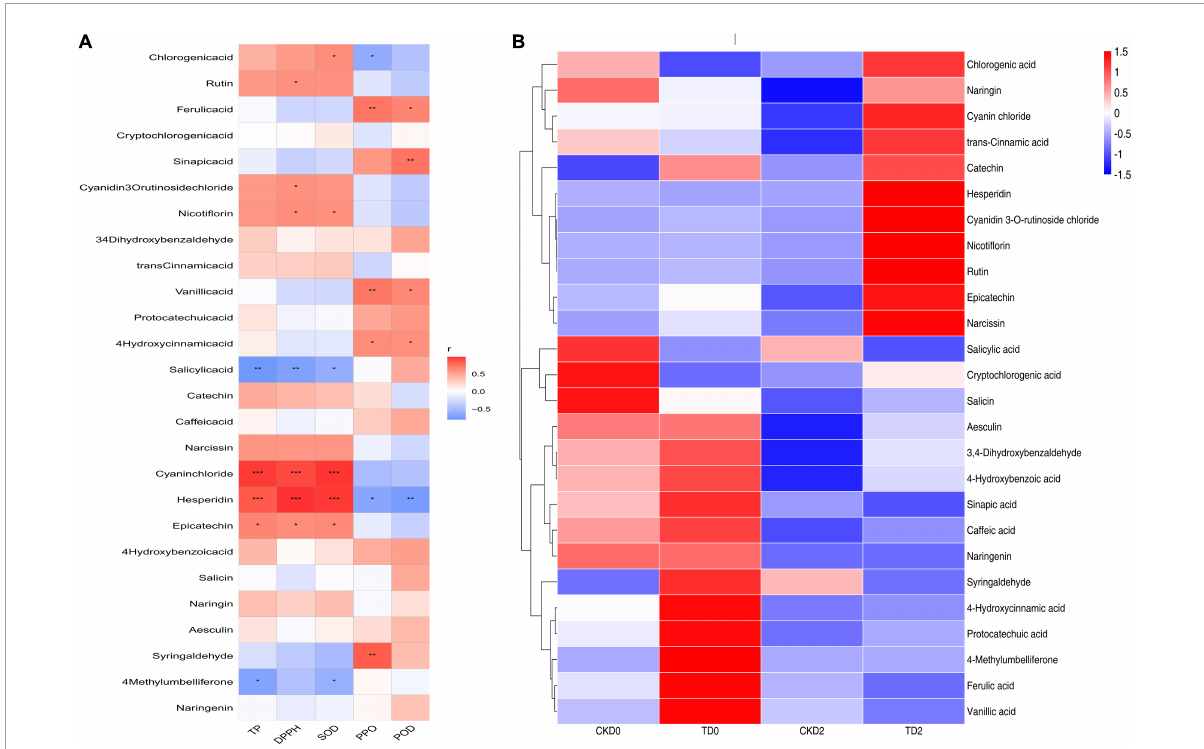
FIGURE8 Heatmap of Spearman’s rank correlations between the individual phenolic compounds and five variables (TP, DPPH, SOD, PPO, and POD) of the fresh-cut pitaya (A) . The heat map of the correlation between individual phenolic compound and the storage time in fresh-cut pitaya fruit (B) . The significance levels are shown below: * p < 0.05; ** p < 0.01; *** p <